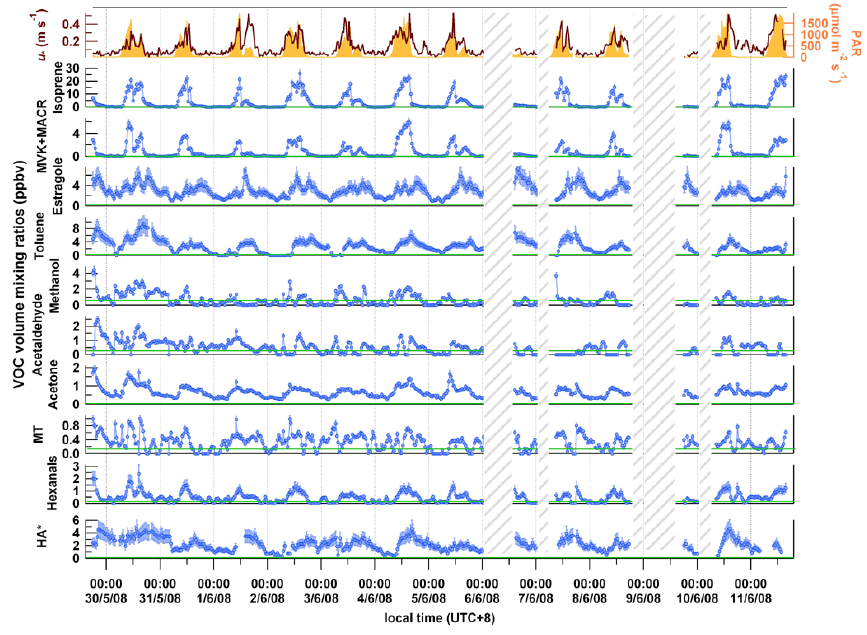
Fig. 2. Time series of volume mixing ratios of 9 compounds included in the flux mode and hydroxyacetone (* derived from the scan mode). Green lines represent